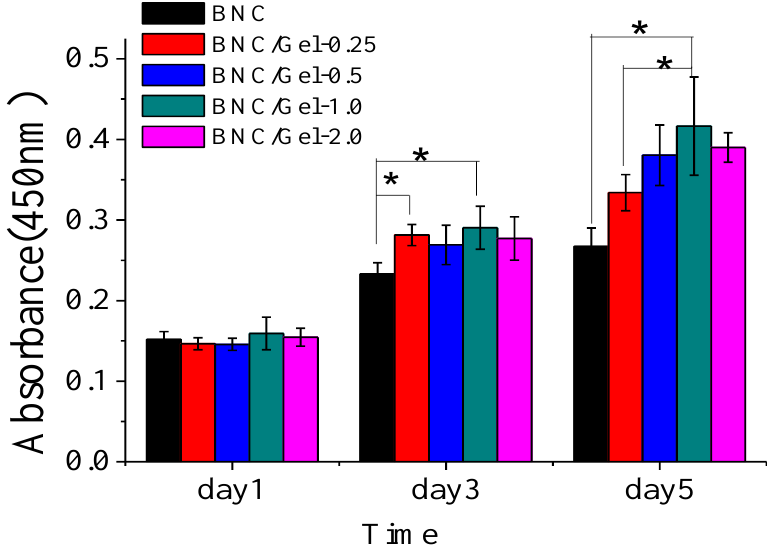
Figure 8. Proliferation of HSMCs on the surfaces of BNC, BNC/Gel-0.25, BNC/Gel-0.5, BNC/Gel-1.0 and BNC/Gel-2.0 tubes (* p < 0.05).